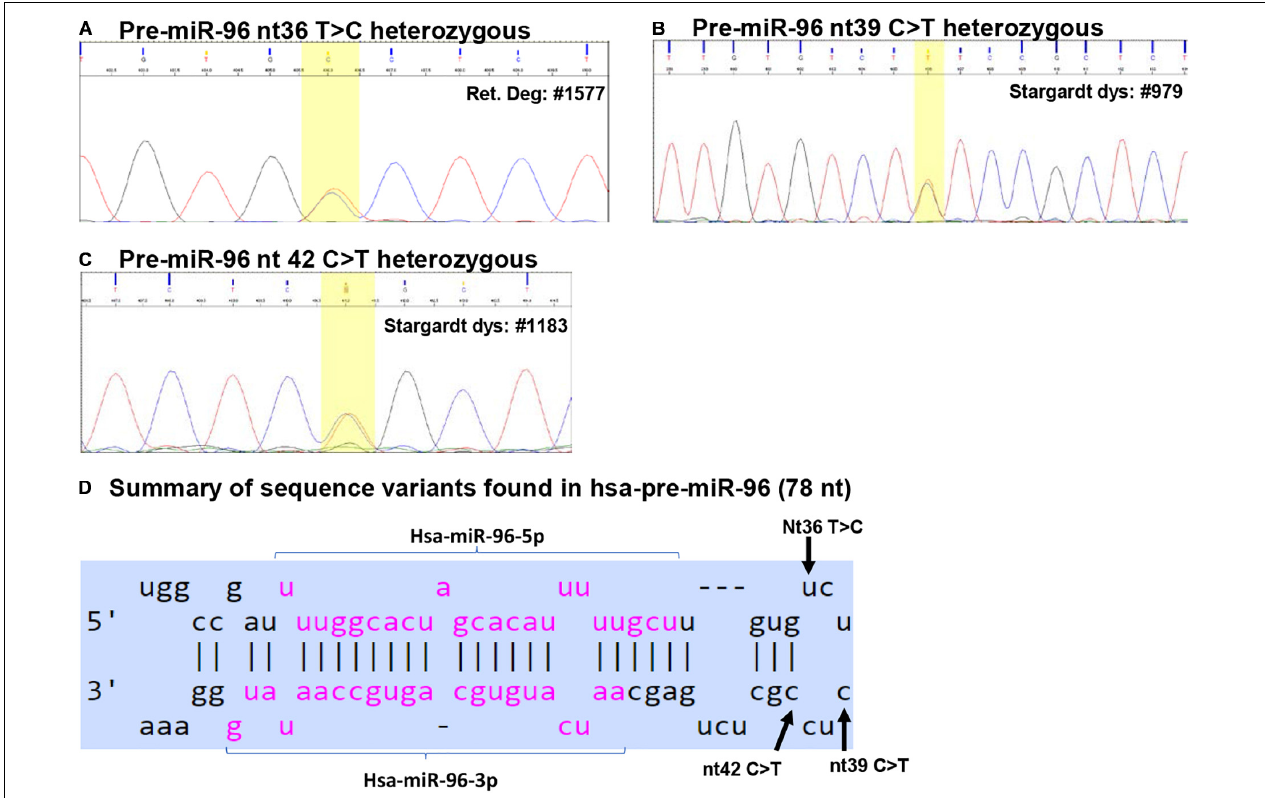
FIGURE 3 | Sequence variants identified in pre-miR-96. (A–C) Example of Sanger sequencing chromatography of patient DNA samples which are heterozygous for pre-miR-96 nt36 T > C (A) , nt39 C > T (B) , and nt42 C > T variants (C) . (D) Summary of the sequence variants of pre-miR-96 in the context of the hairpin structures of pre-miR-96. Reference: